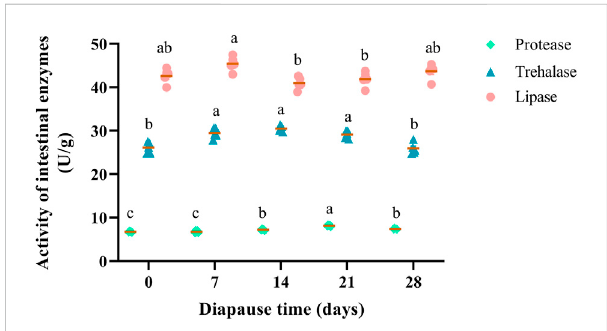
FIGURE 3 Effect of diapause time on the activity of intestinal enzymes (protease, trehalase and lipase) in C. bilineata tsingtauica larvae. Data are mean ± SEM. Different lowercase letters denote signi fi cant difference among diapause time by Tukey test at p < 0.05.